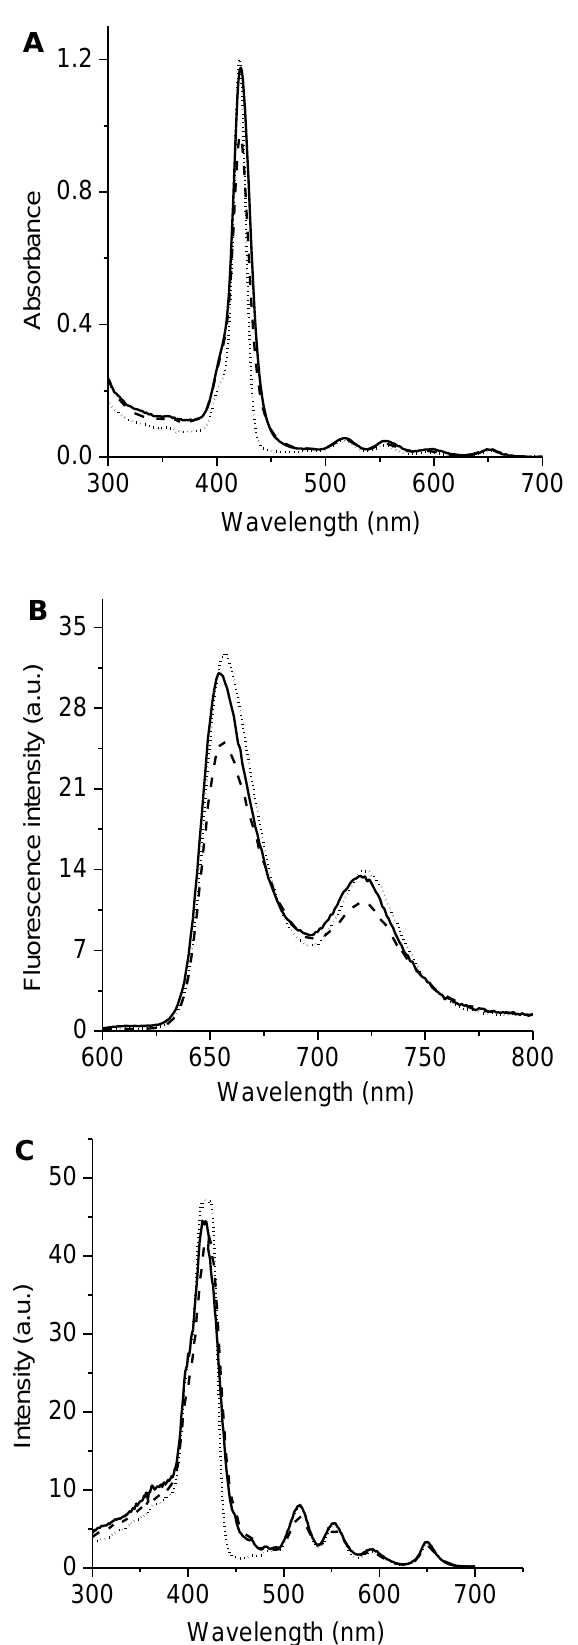
Figure 2. ( A ) Absorption, ( B ) fluorescence emission ( λ exc = 517 nm), and ( C ) excitation ( λ em = 720 nm) spectra of 6 (solid line), 7 (dashed line), and TMP (dotted line) in DMF.